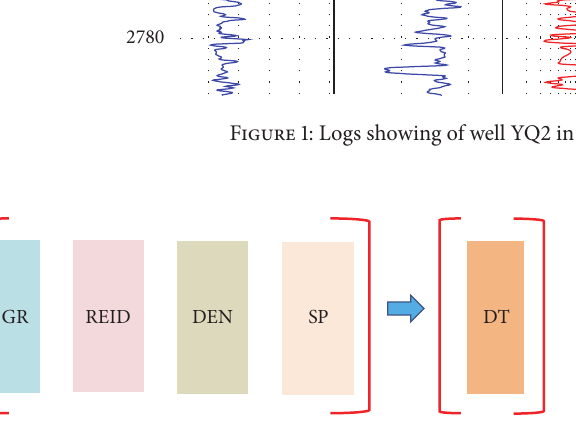
Figure 2: Example of multi-input versus single-output sonic log prediction using KELM. Details about the well logging parameters depicted in the figure are given in